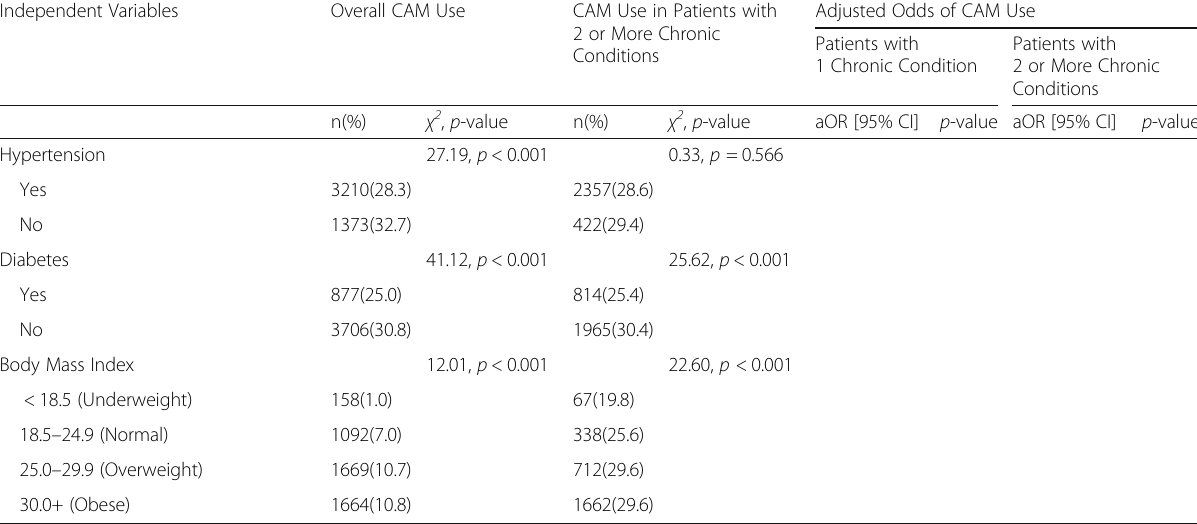
Table 2 Proportions and odds of CAM use among adults with and without comorbidities (Continued) Independent Variables Overall CAM